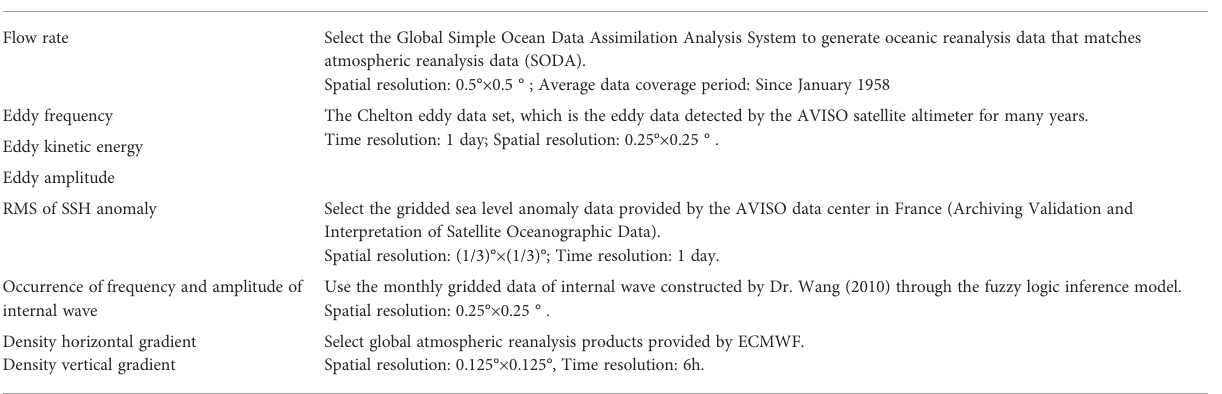
TABLE 2 Data sources of evaluation